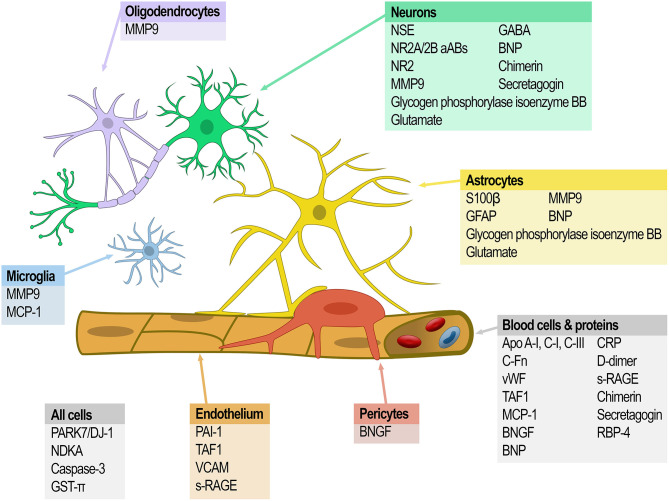
Sources of the major candidate biomarkers.